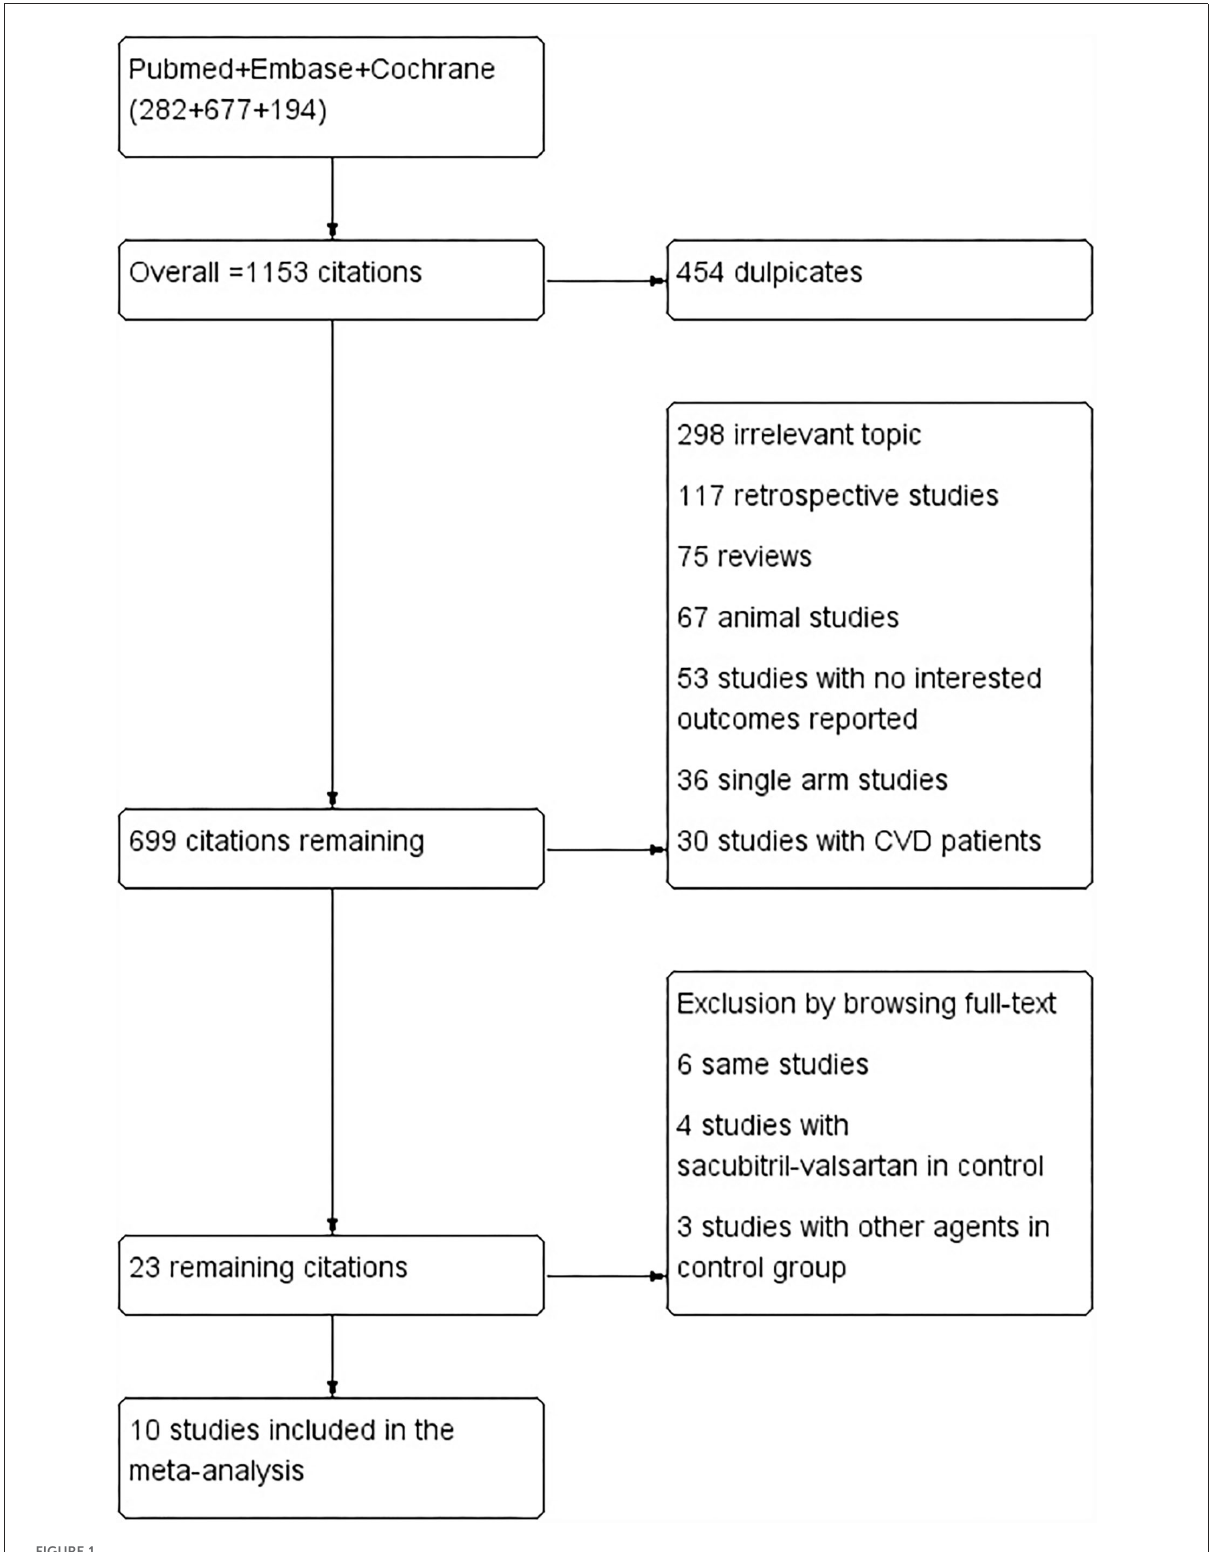
FIGURE1 Flowchart diagram of citation